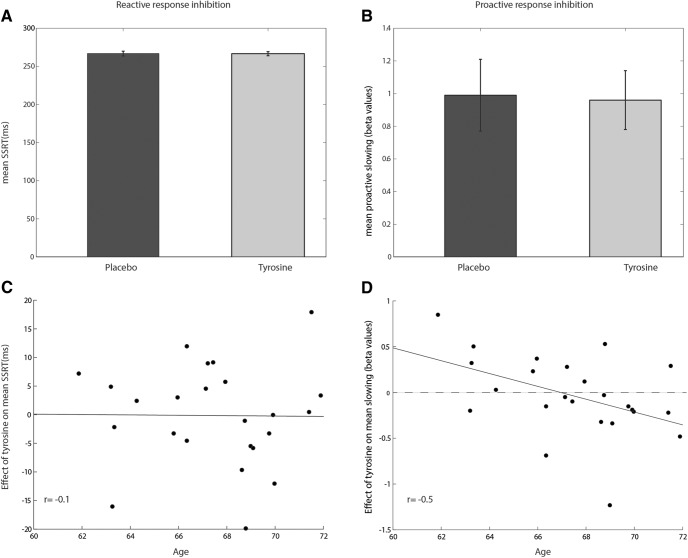
A, SSRT on placebo and tyrosine session across levels. B, Proactive β slowing slopes on placebo and tyrosine session. Data represents mean, error bars represent SEM. C, The effect of tyrosine compared with placebo on SSRT was not modulated by age (r = −0.1, p = 0.96). D, With increasing age, tyrosine relative to placebo attenuated proactive RT slowing (r = −0.45, p = 0.03), i.e., the degree to which participants slowed their responses with increasing stop-signal probabilitya,b.